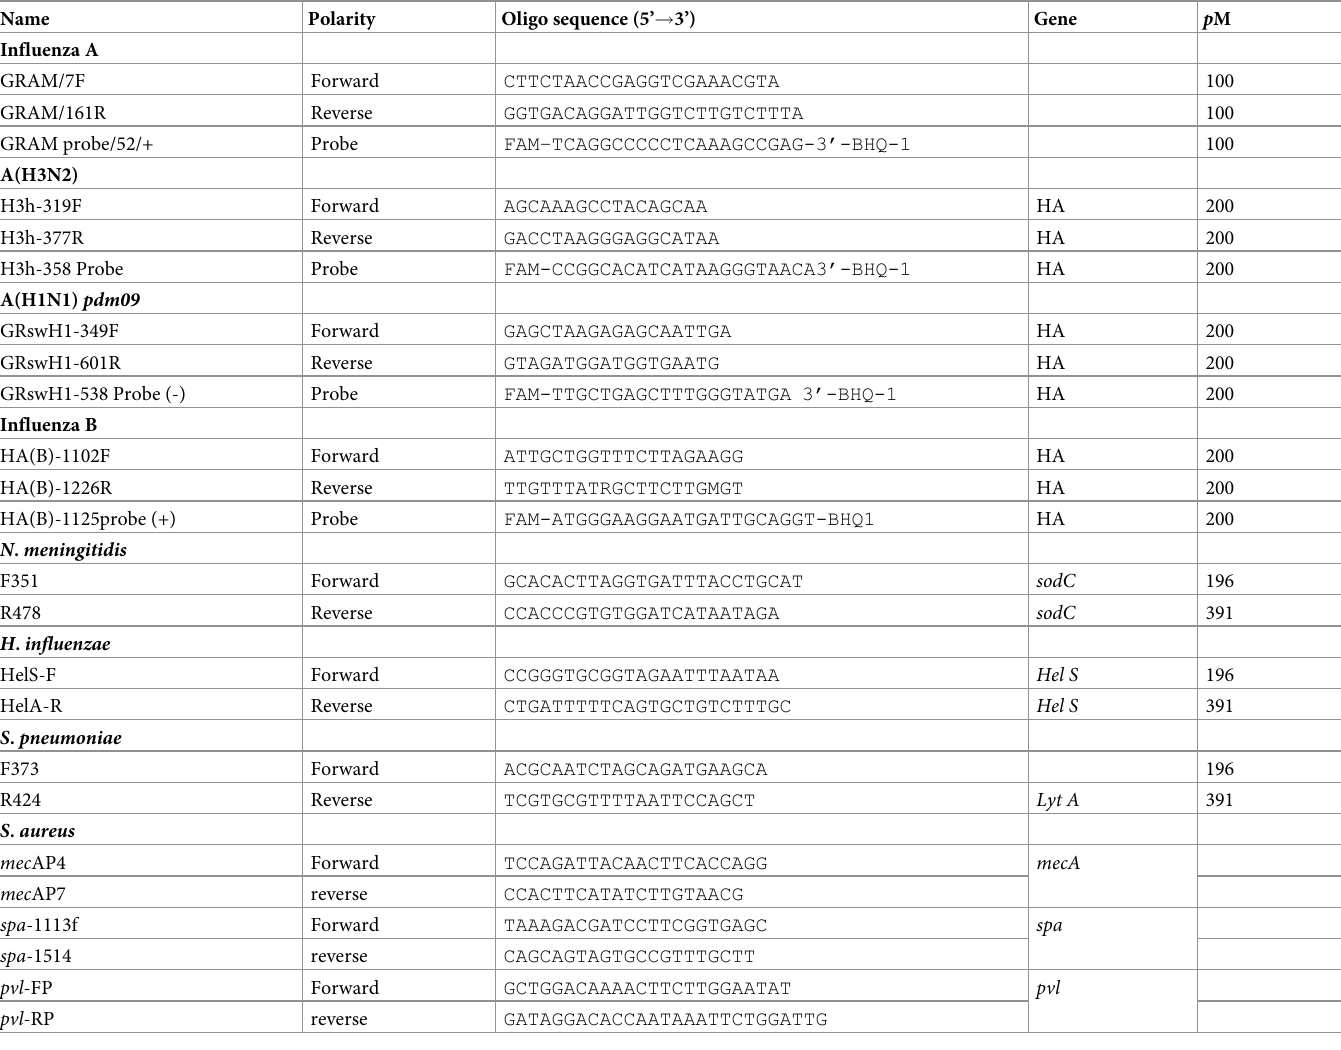
Table 1. Oligonucleotides sequences for